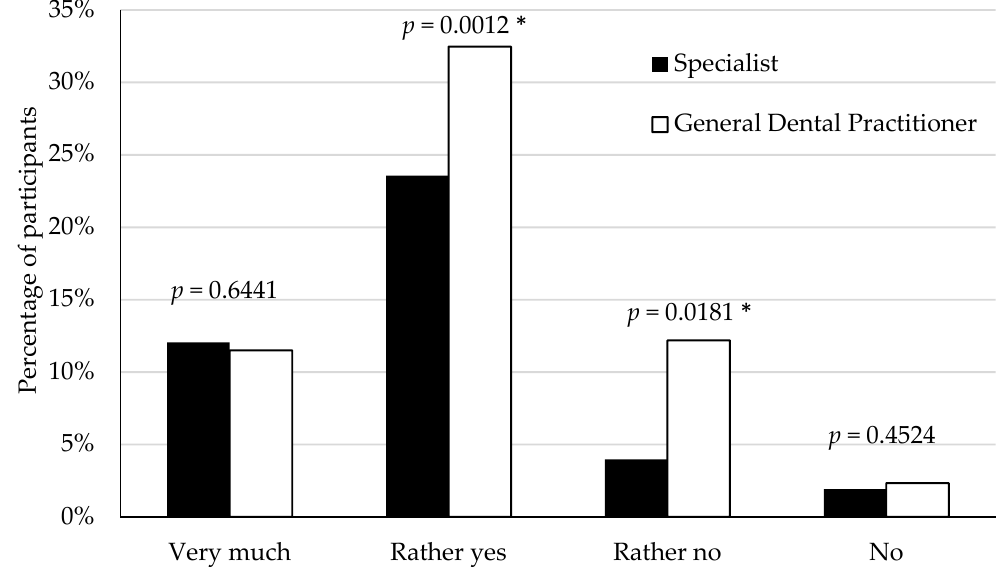
Figure 2. Feeling anxious about the situation related to the COVID-19 pandemic among general dental practitioner and specialists (* significant difference at p < 0.05 by way of the Chi square test).